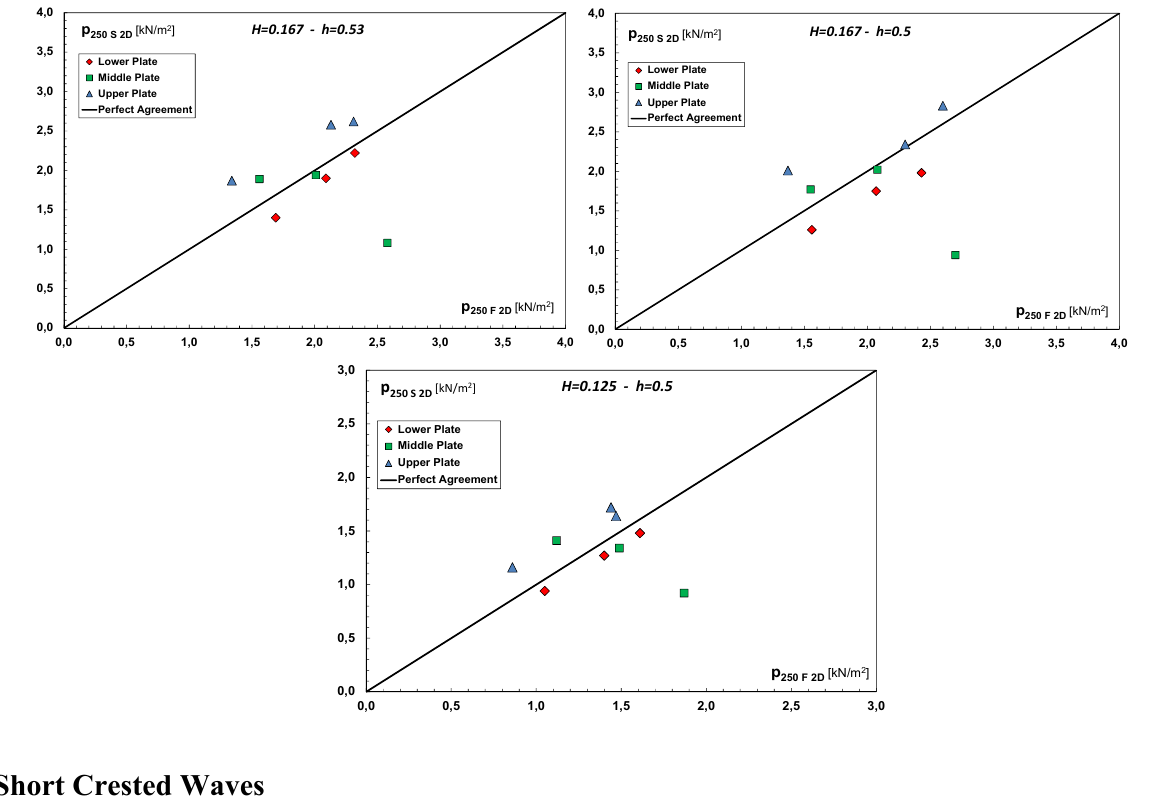
Figure 20. Wave pressures for front and side long crested wave attacks; data refer to couple of tests having the same wave height and period. Top left panel: H = 1.81 s, h = 0.53 m. Top right panel: H T p H = 0.125 m, T = 1.55 s, h = 0.50 s p